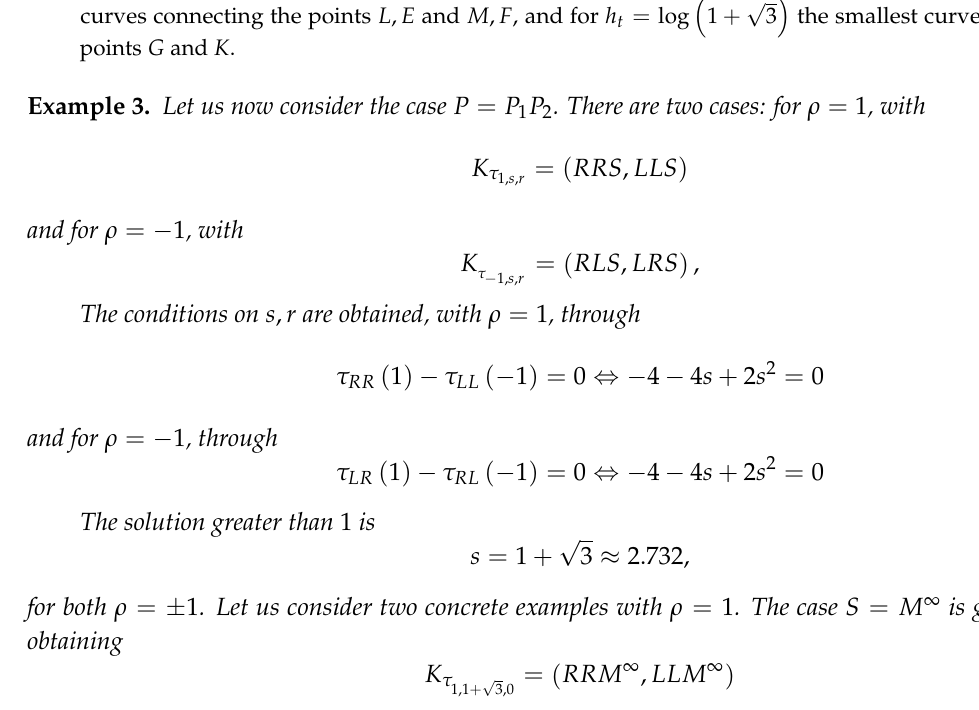
√ (cid:16) (cid:17) 1 + 3 the smallest curves near the